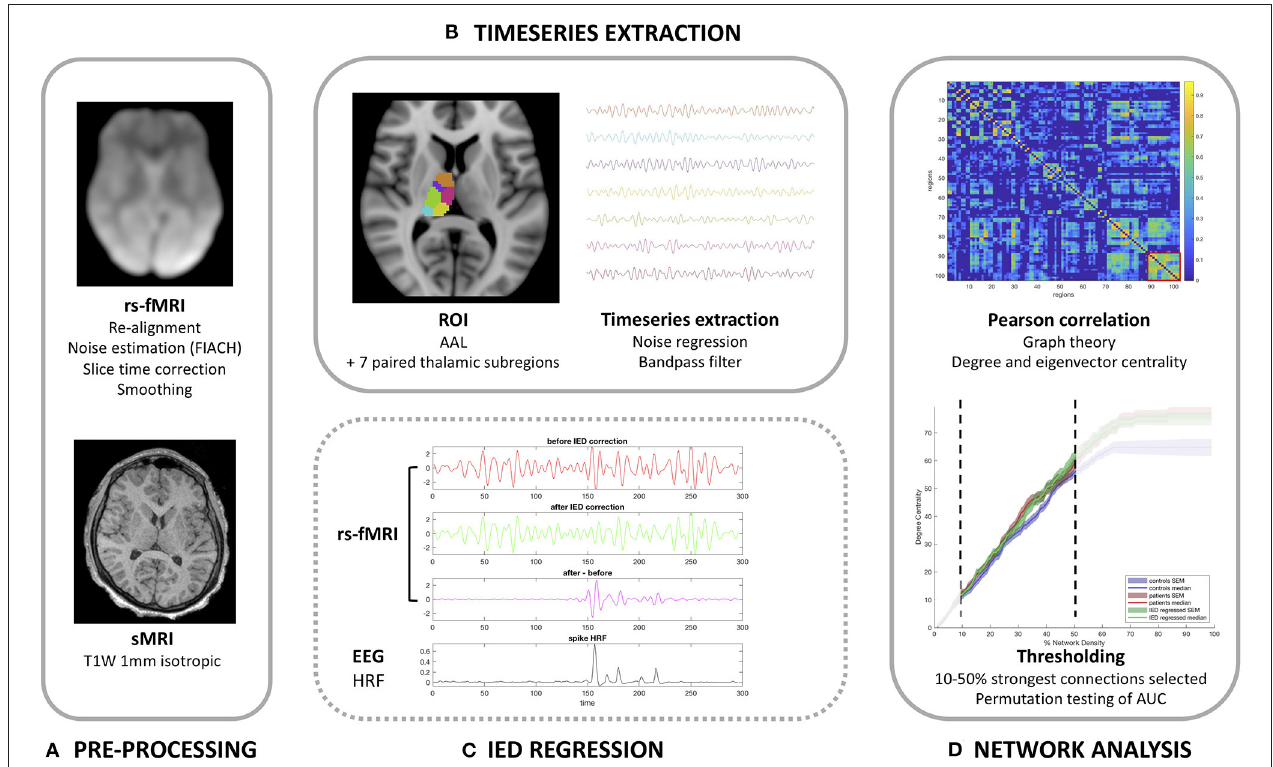
FIGURE 1 | Imaging analysis pipeline. (A) Pre-processing pipeline. (B) Timeseries extraction. (C) Demonstration of the correction method for interictal epileptiform discharges (IEDs) in the anterior nucleus of the thalamus for patients 13 (one spike type) as detailed in Table 1 . (D) Functional network